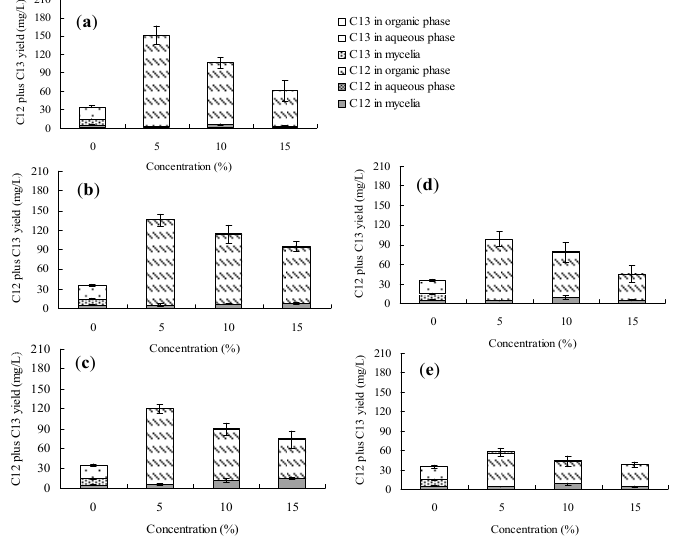
Figure 3. Effects of dibutyl phthalate on palmarumycin production in liquid culture of Berkleasmium sp. Dzf12. Dibutyl phthalate was applied at 0%, 5%, 10% and 15% on days 0 ( a ); 3 ( b ); 6 ( c ); 9 ( d ) and 12 ( e ) of culture, respectively. The period of culture lasted for 15 days. “C12” means palmarumycin C 12 , “C13” means palmarumycin C 13 . The error bars represent standard deviations from three independent samples.